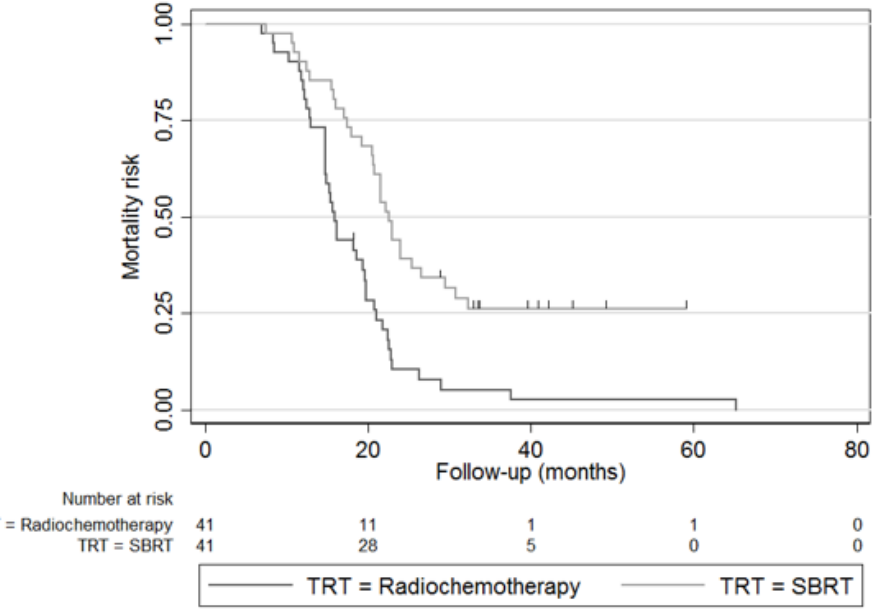
Figure 1. Kaplan–Meier plot of overall survival of the iHD-SBRT and CRT cohort ( n = 82).